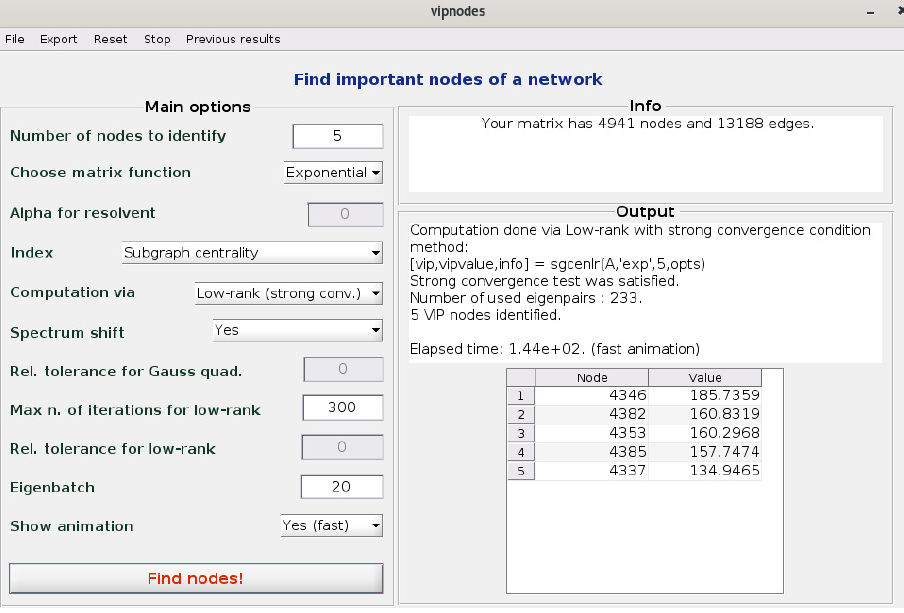
Figure 4. Main window after the identification of the five most important nodes for the Power network by the low-rank approximation method.